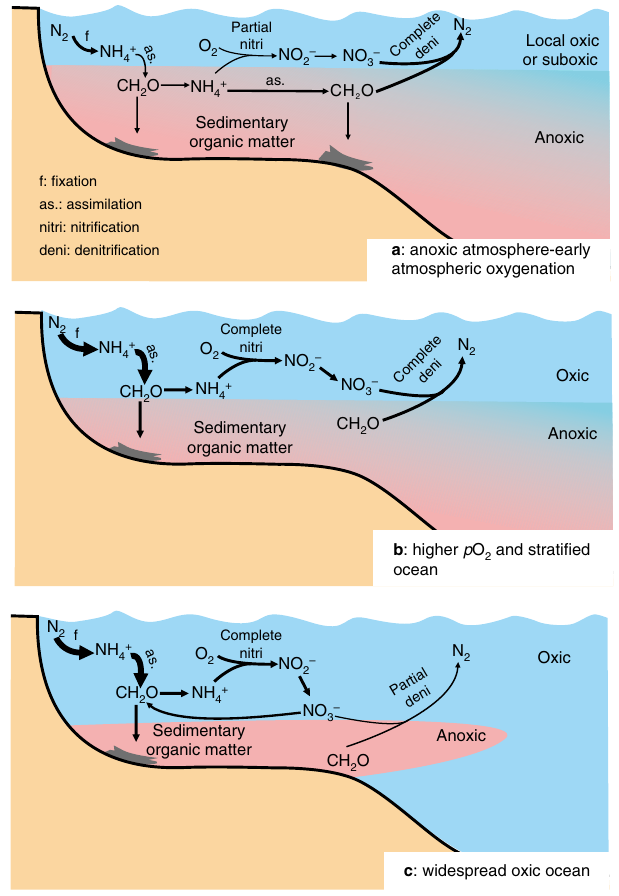
Fig. 5 Schematic model of the evolving marine nitrogen cycle in response to increasing atmospheric p O 2 . a shows the pre-GOE to early GOE (dissolved O 2 content < 11 μ M; fi rst stage of Fennel et al. 15 ), when the rate of nitrate loss via denitri fi cation exceeded its replenishment via nitri fi cation. Here, ammonium was relatively stable and potentially served as the main source of biologically available nitrogen. b depicts the nitrogen cycle after a further increase in environmental oxygen availability (dissolved O 2 content > 11 μ M; potentially second stage of Fennel et al. 15 ), with quantitative nitri fi cation and denitri fi cation destabilising nitrate and ammonium. Microbial nitrogen fi xation served as the main source of biologically available nitrogen. c depicts the contemporary nitrogen cycle dominated by nitrate in a predominantly oxygenated ocean. We hypothesise that a encompasses the upper Rooihoogte Formation to the lower Timeball Hill Formation, b encompasses the lower part of the upper Timeball Hill Formation and c represents the uppermost Timeball Hill Formation and following Lomagundi